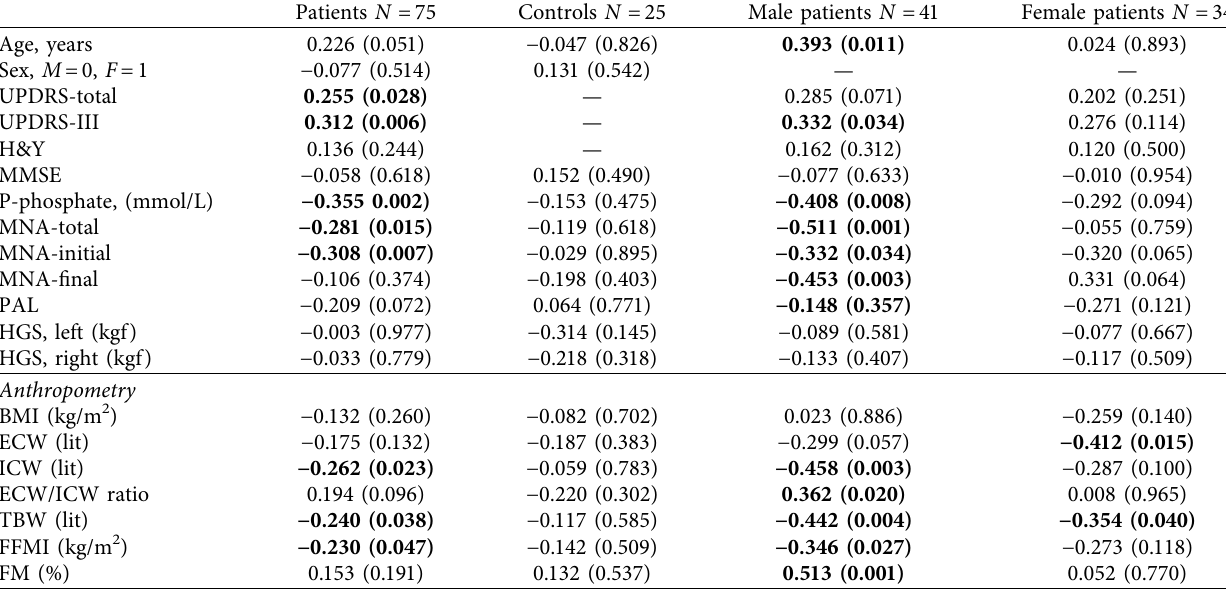
Table 2: Bivariate correlations r ( P value) between daytime P-cortisol levels and characteristics, including plasma phosphate and body composition variables at time of diagnosis.